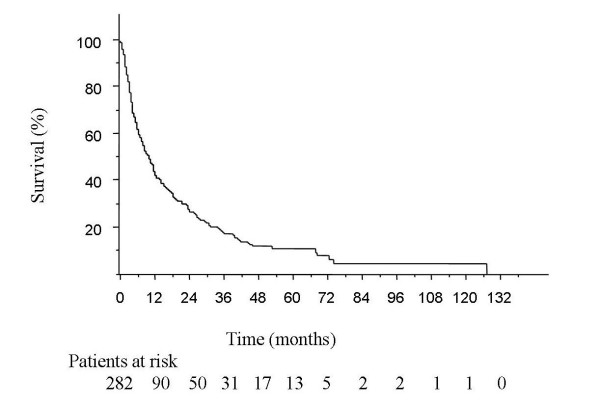
Overall survival. The median overall survival was 9.7 ± 1.0 months.